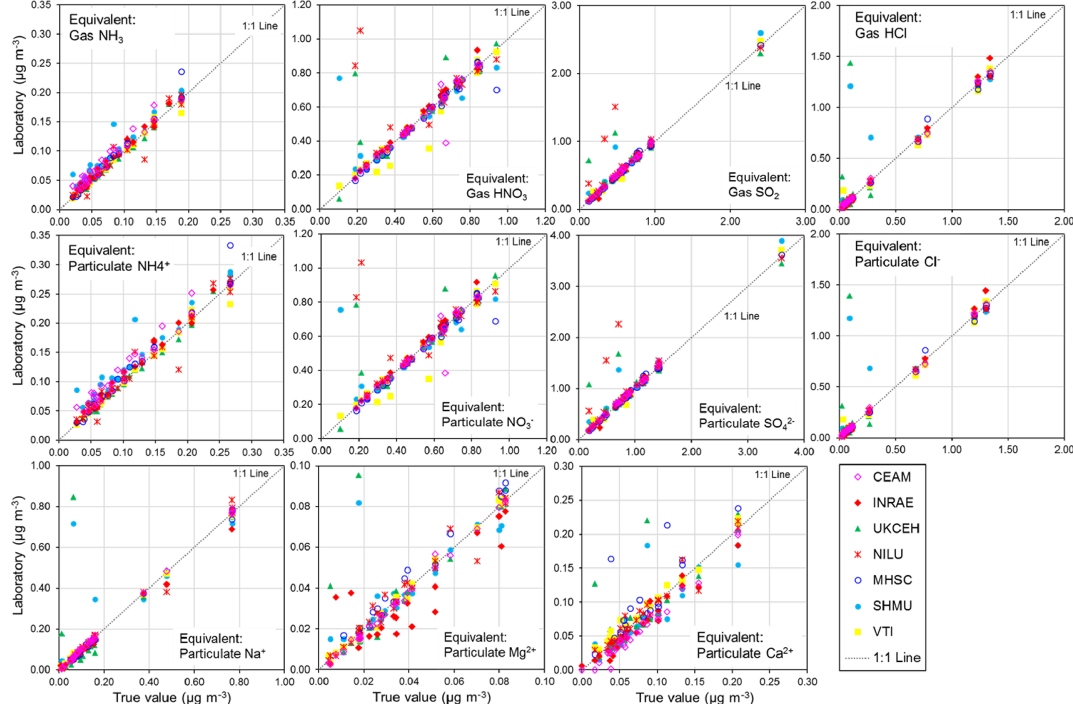
Figure 5. Scatterplots comparing all NEU laboratory-reported results from wet chemistry proficiency testing (PT) schemes (2006–2010: EMEP, WMO-GAW, and NitroEurope) vs. true values (PT reference solutions). All aqueous ion concentrations (mgL − 1 ) from Fig. 4 are converted to equivalent gas and aerosol concentrations (µgm − 3 ) for the